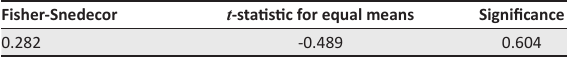
TABLE 6: Levene’s test of equality of error variances. Fisher-Snedecor